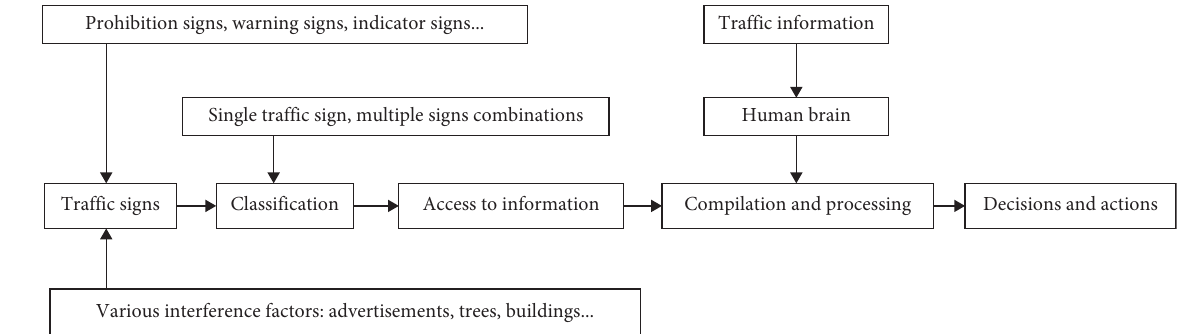
Figure 1: The information transmission model in DTSC.